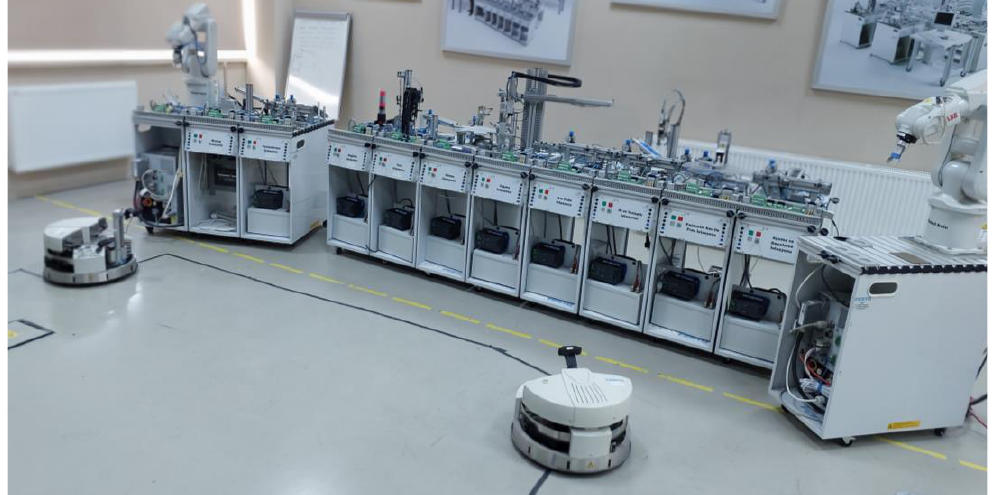
Figure 9. Workspace prepared for physical testing.